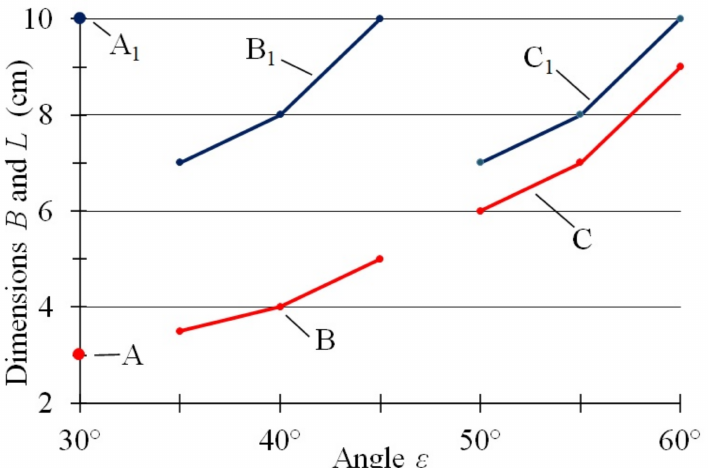
Figure 10. Dependence of parameters B ( — ) and L ( — ) of the harrow tine on the value of the angle epsilon for different values of the angle γ : 60 ◦ (point A, A 1 ); 45 ◦ (curve B and curve B 1 ); and 30 ◦ (curve C and curve C 1